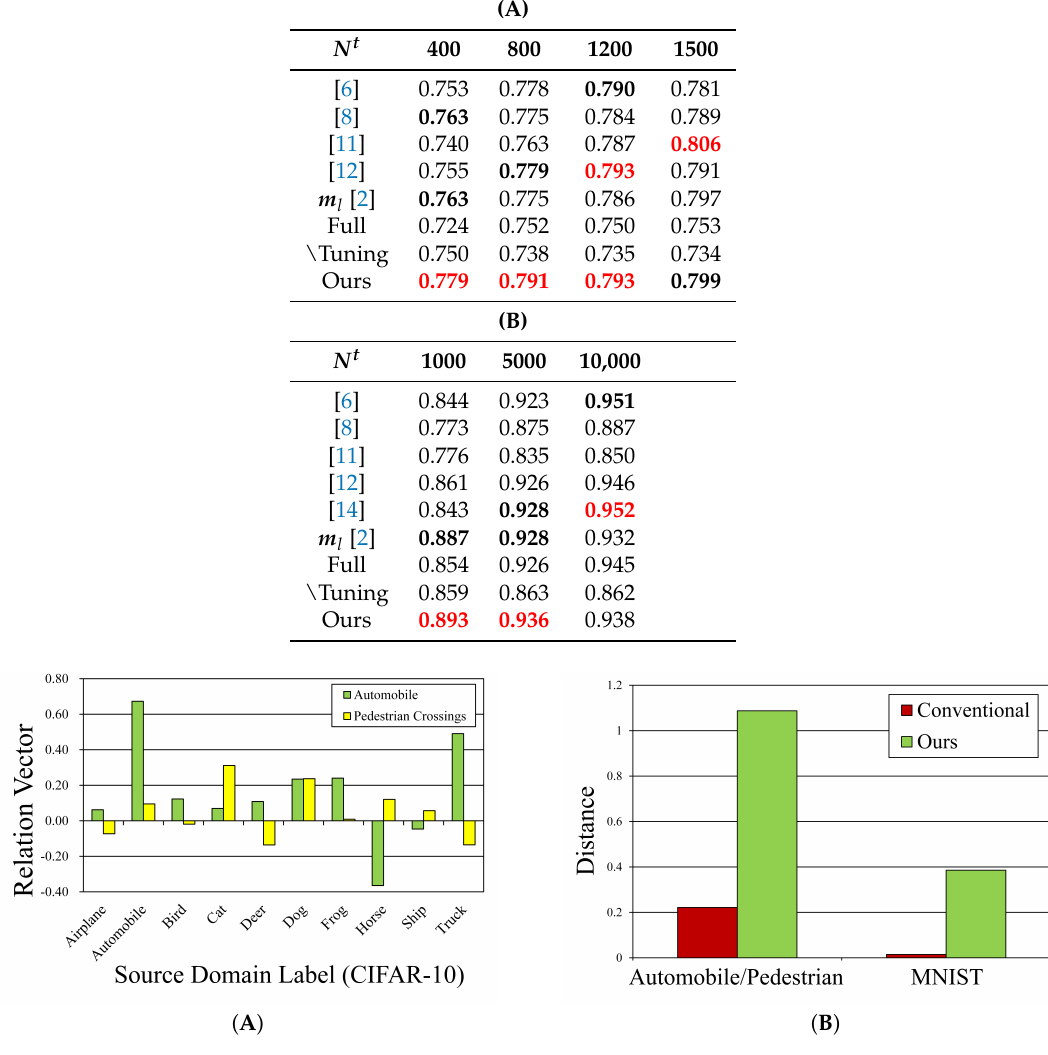
Figure 3. Results of relation vectors. ( A ) Example of relation vectors for Task (2) estimated by our method. ( B ) The distance between relation vectors of conventional ATDL [2] and our proposed